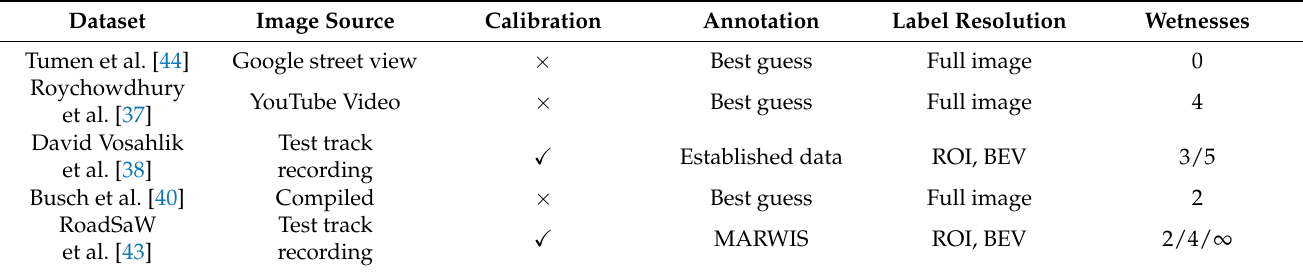
Table 5. Comparison of existing datasets in RSC detection